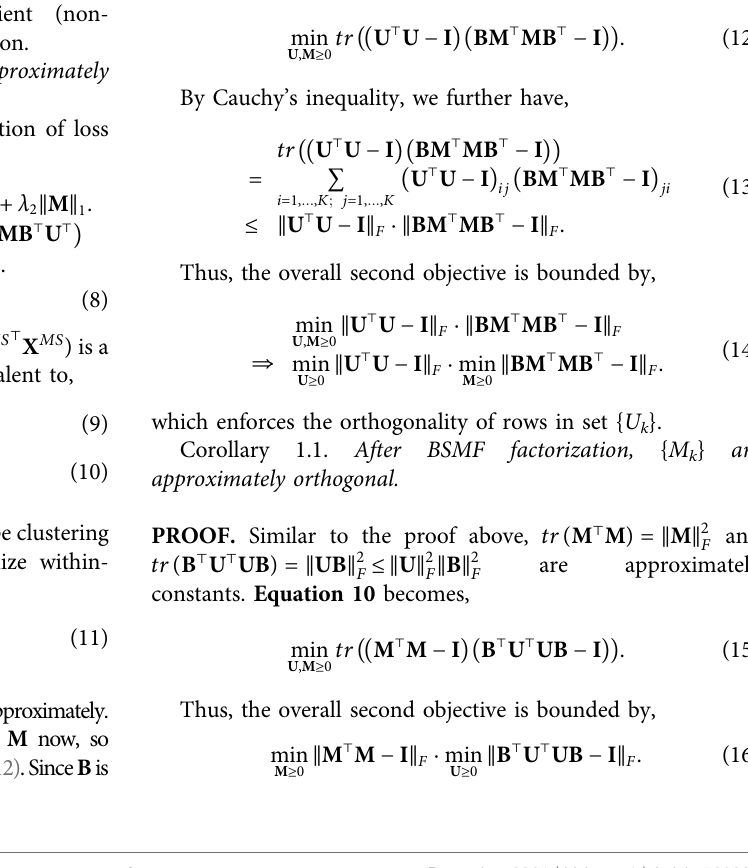
Frontiers in Big Data |